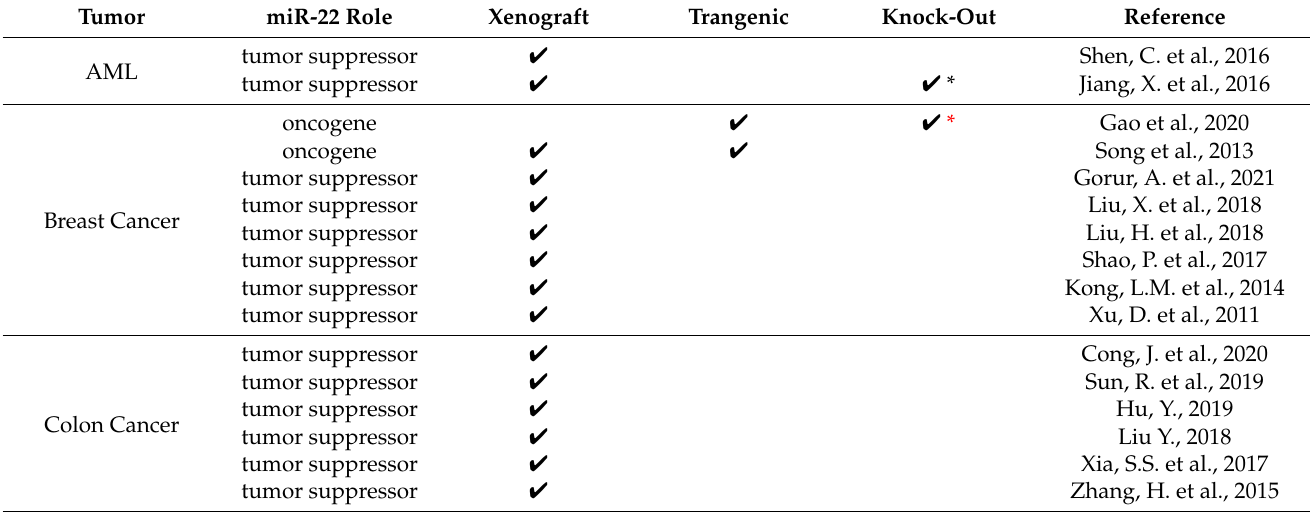
Table 2. miR-22 role in several in vivo -based cancer